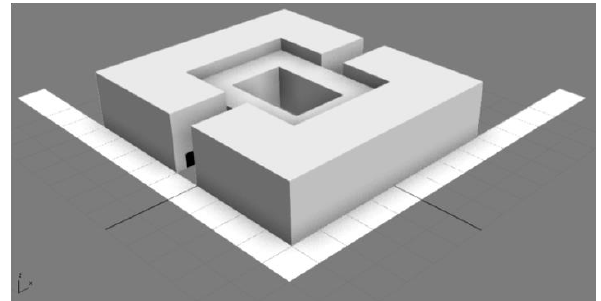
Figure 2. Colonial Merida housing at corner lot. In middle lots, the house started with front and rear bay corridors, following the creation of sequenced patios. The interconnections between courtyards were very diverse.